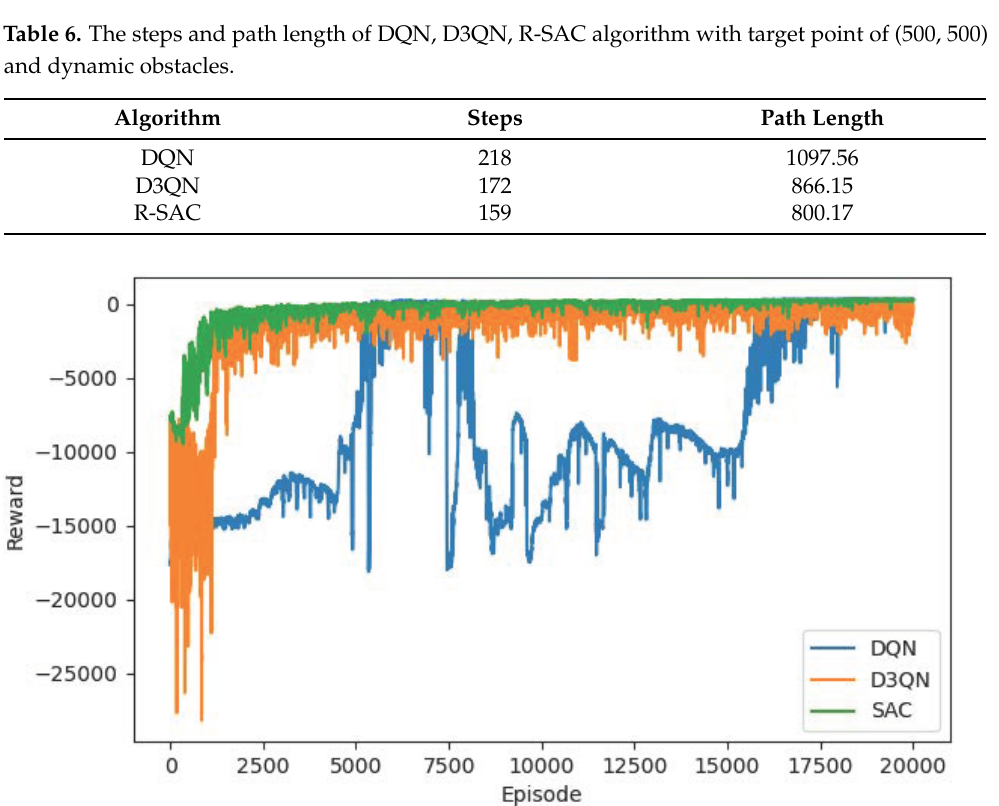
Figure 12. The reward curves of DQN, D3QN, R-SAC algorithm with target point of (500, 500) and dynamic